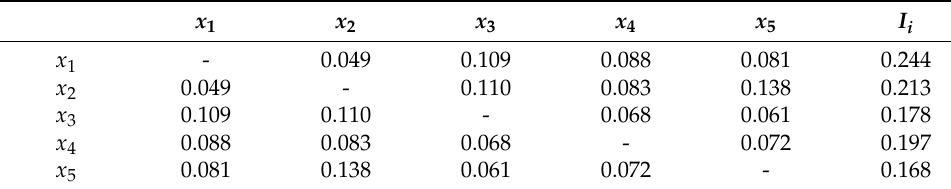
Table 2. Estimations of attributes pair interaction indexes and importance values.